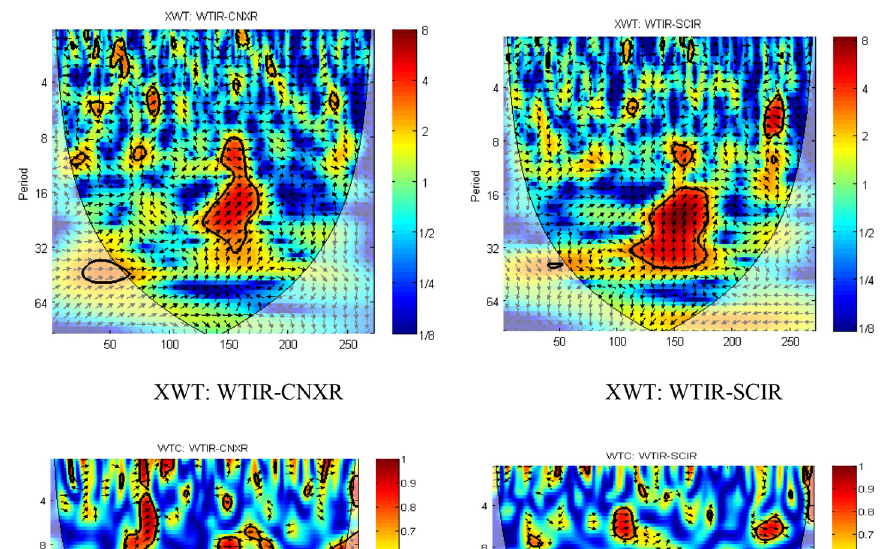
Figure 8. WTC between WTI crude oil prices and exchange rate and stock indices of India and China